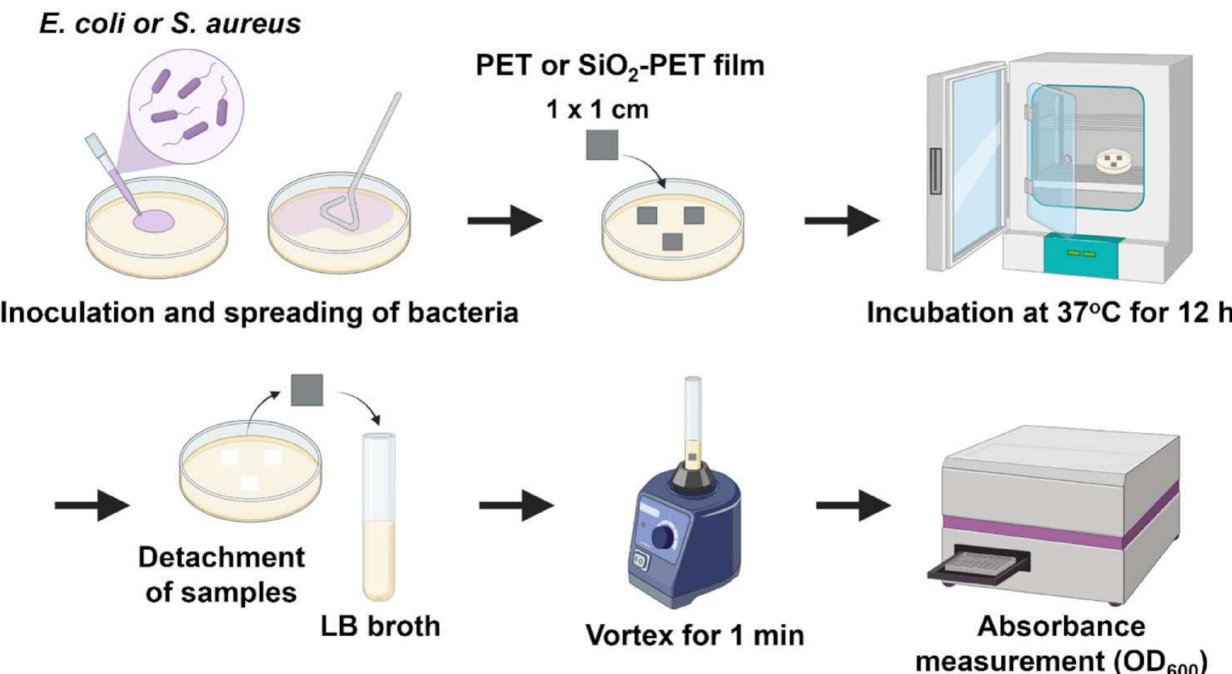
Figure 3. A schematic illustration of the antibacterial assay—created with BioRender.com (accessed on 25 October